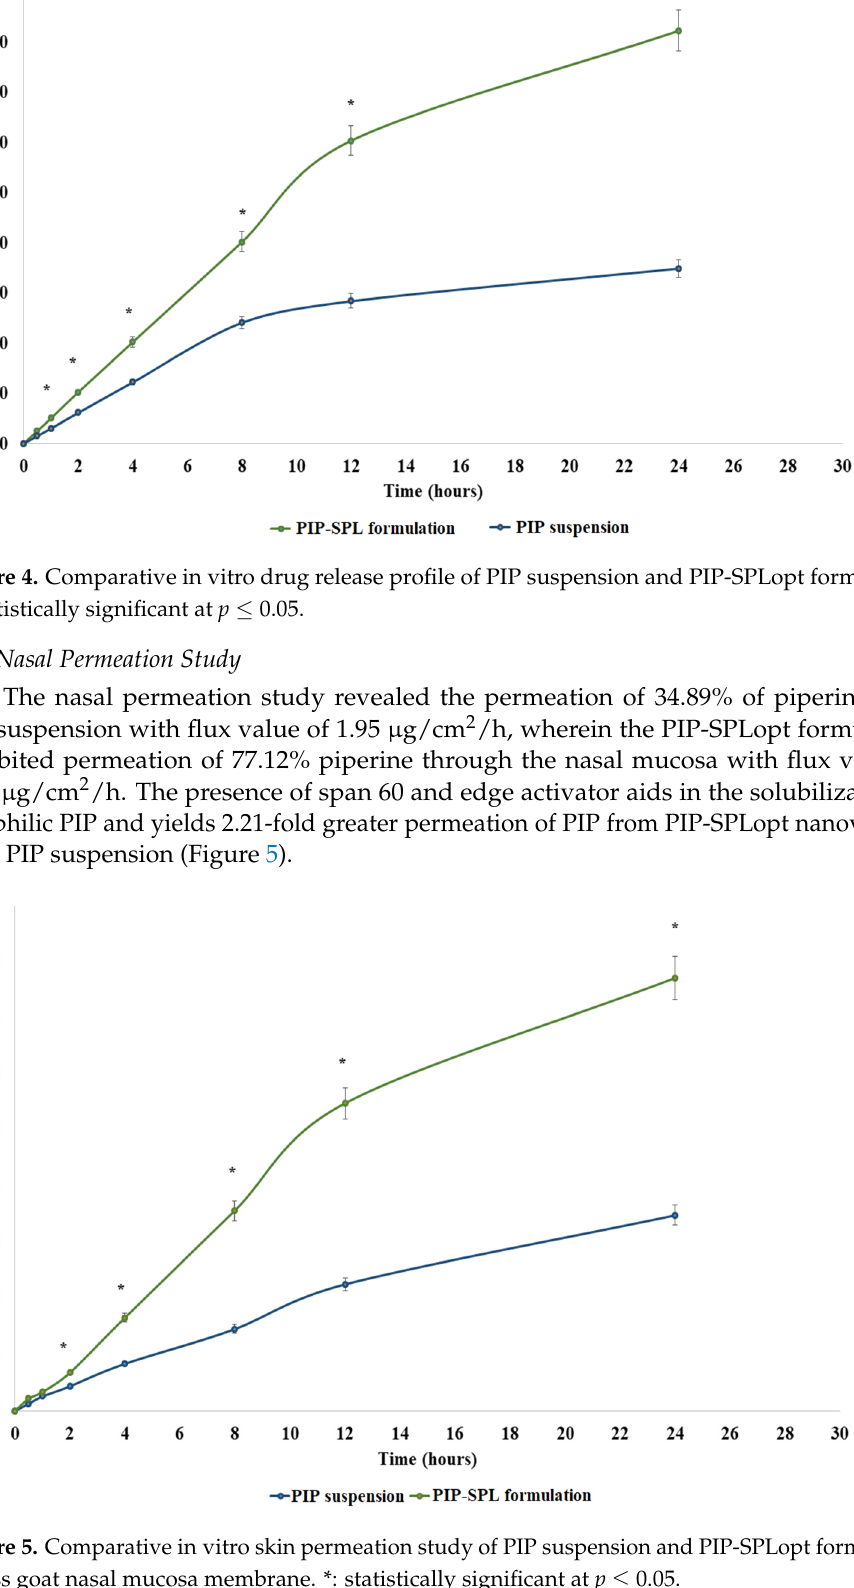
12 of 21 Table 3. Invitro drug release kinetics with correlation values.